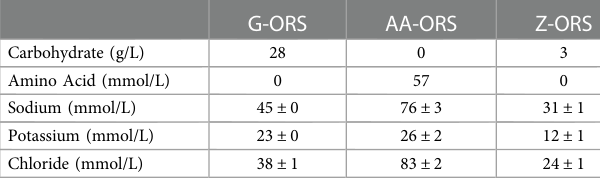
TABLE 2 Oral rehydration solution (ORS) compositions.